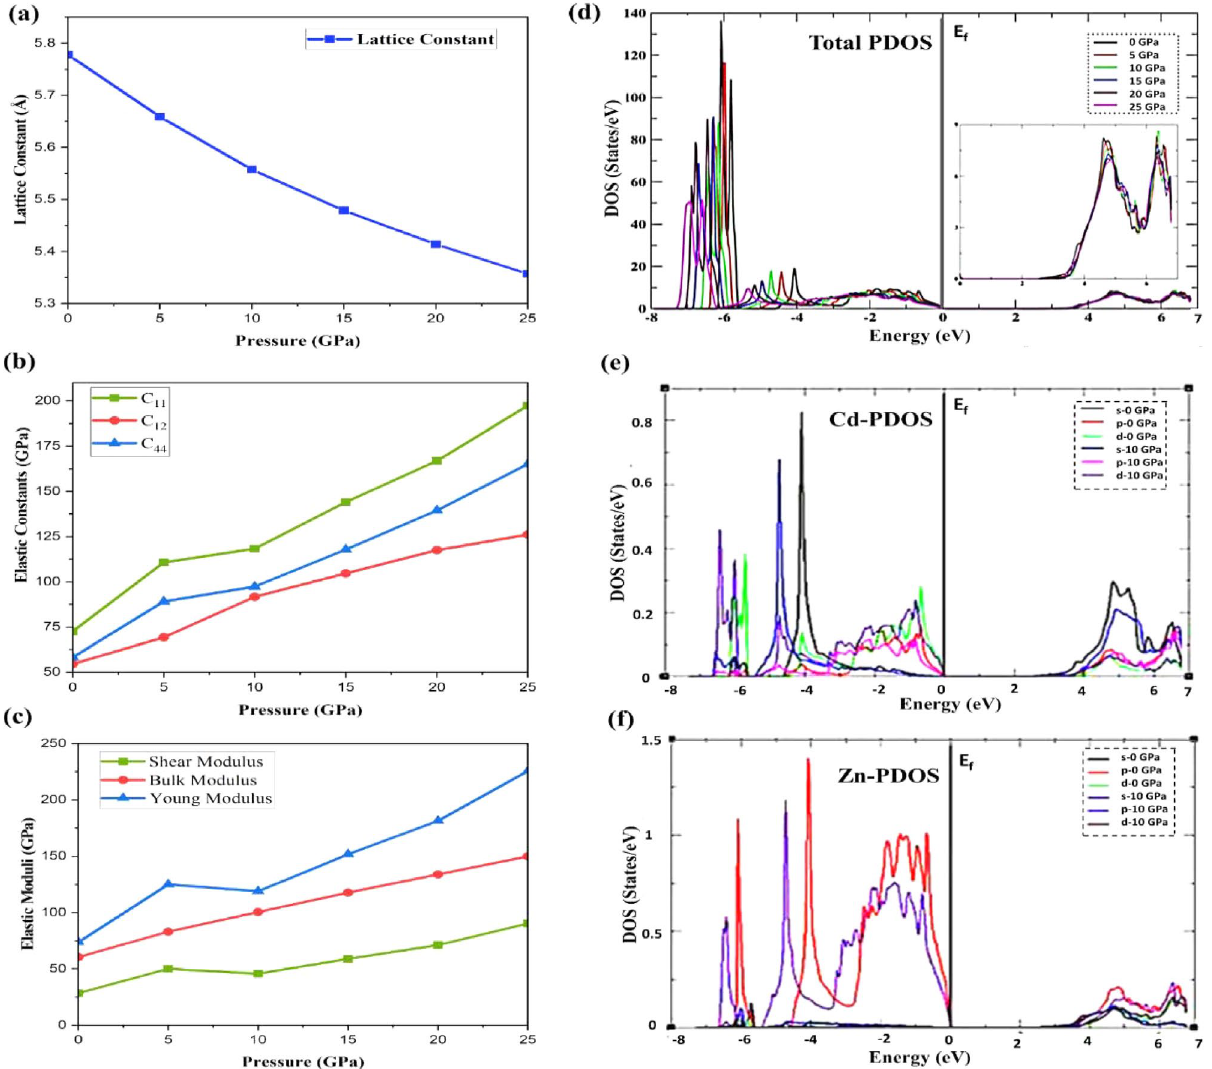
Figure 1. Elastic constants and density of states analysis under the influence of pressure, ( a ) lattice constant variation, ( b ) C 11 , C 12 , C 14 variation, ( c ) shear moduls, bulk modulus, young modulus variation, ( d ) TDOS of Cd 0.25 Zn 0.75 Se alloy, ( e ) PDOS of Cd-atom, and ( f ) PDOS of Zn-atom.